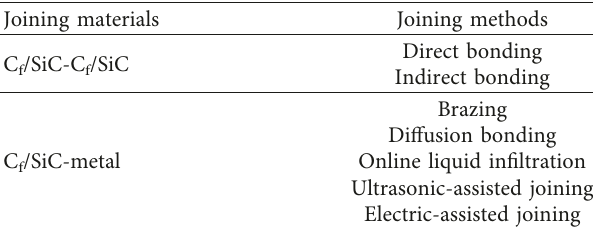
Table 1: Commonly used joining methods of C